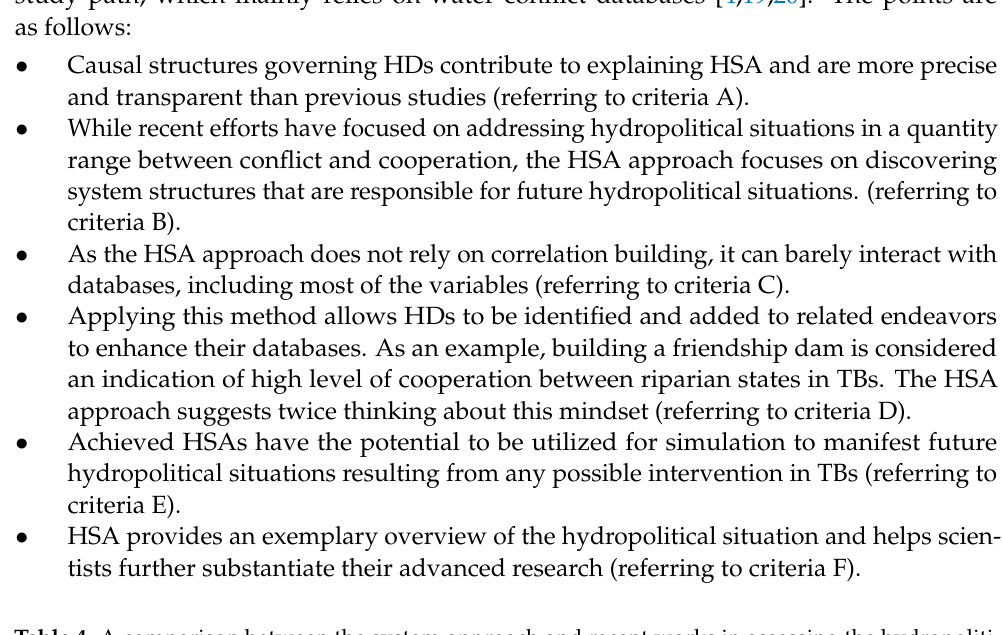
Table 4. A comparison between the system approach and recent works in assessing the hydropoliti- cal